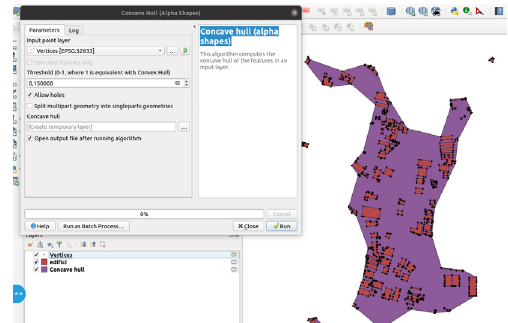
Figure 3 . Example application of the Concave Hull tool (alpha shapes). The point data obtained earlier with 'extract vertices' should be selected as input.